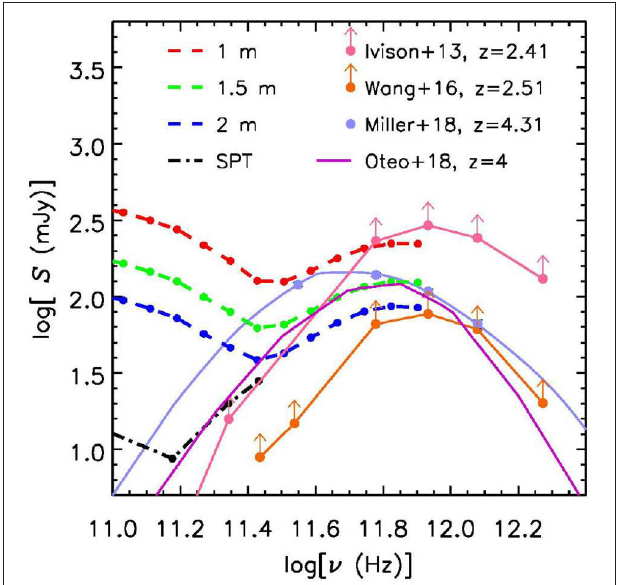
FIGURE 6 | SEDs of spectroscopically confirmed sub-mm bright high- z proto-clusters detected by Ivison et al. (2013), Wang et al. (2016), Miller et al. (2018), and Oteo et al. (2018), compared with (from top to bottom) the detection limits of diffraction limited space-borne telescopes of 1, 1.5, and 2m size, and with the SPT completeness limit. The flux densities by Ivison et al. (2013) and Wang et al. (2016) are shown as lower limits because they include the contributions of member galaxies across a ∼ 100kpc region, substantially smaller than the expected proto-cluster size ( ∼